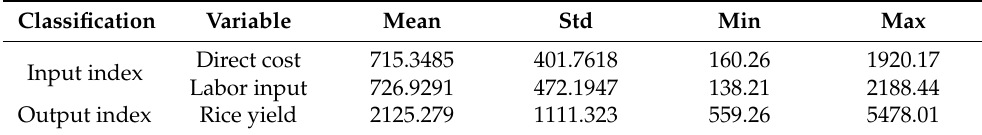
Table 1. Index System of Rice Production